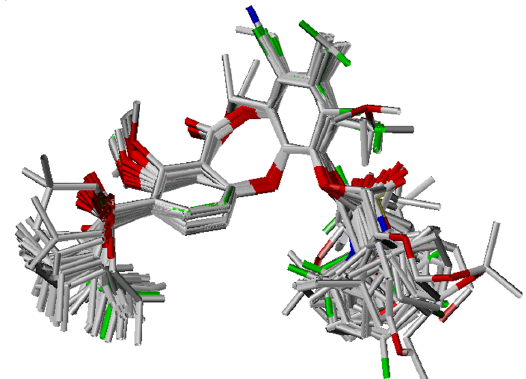
Figure 8. Alignment of the lactone-based analogues from the training